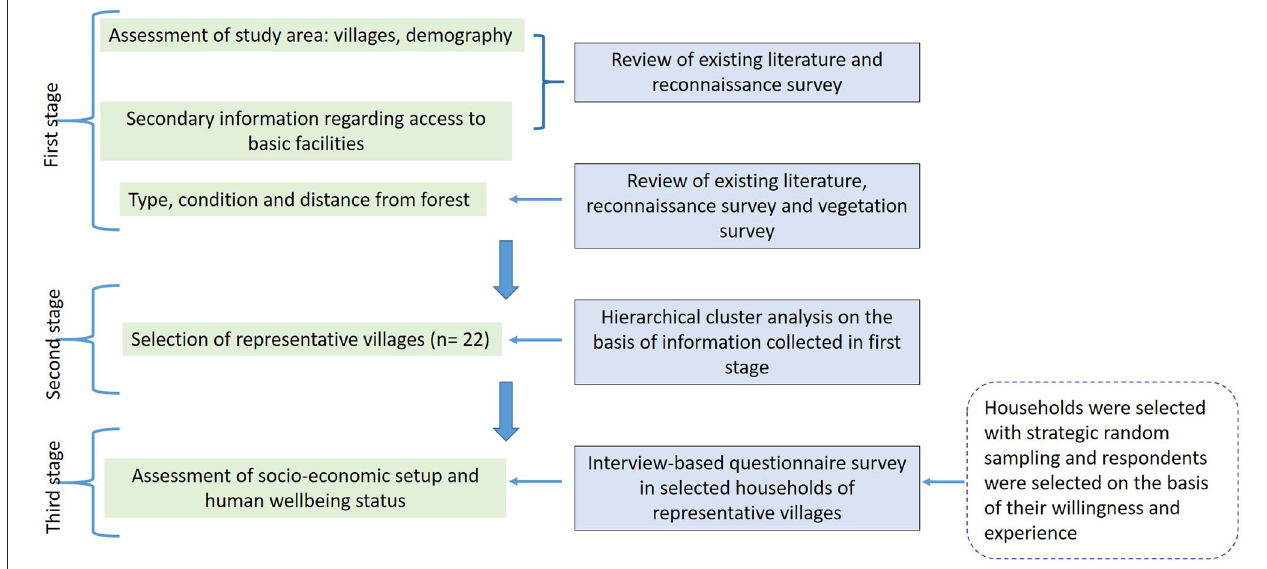
FIGURE 2 | Process followed to assess the human wellbeing status of forest-dependent communities in the NDBR.